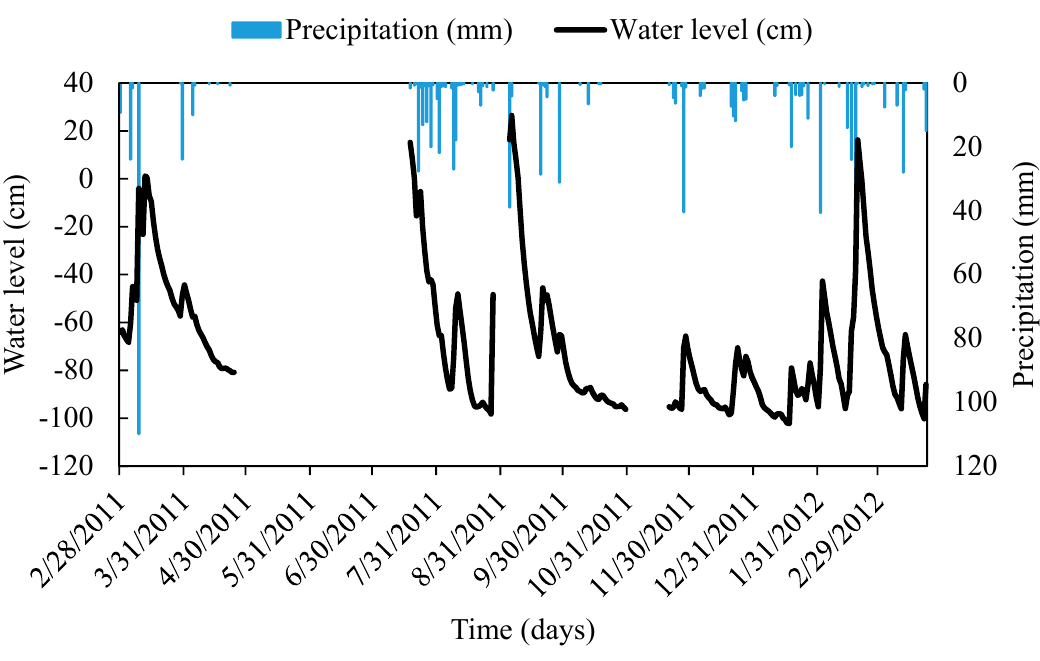
Figure 2. Water level recorded at the study wetland; there was no water level (WL) data available for the study wetland from 25 April 2011 to 17 July 2011. Note that there were two other periods of missing data for the study site. Altogether, water level data were available for 279 days.